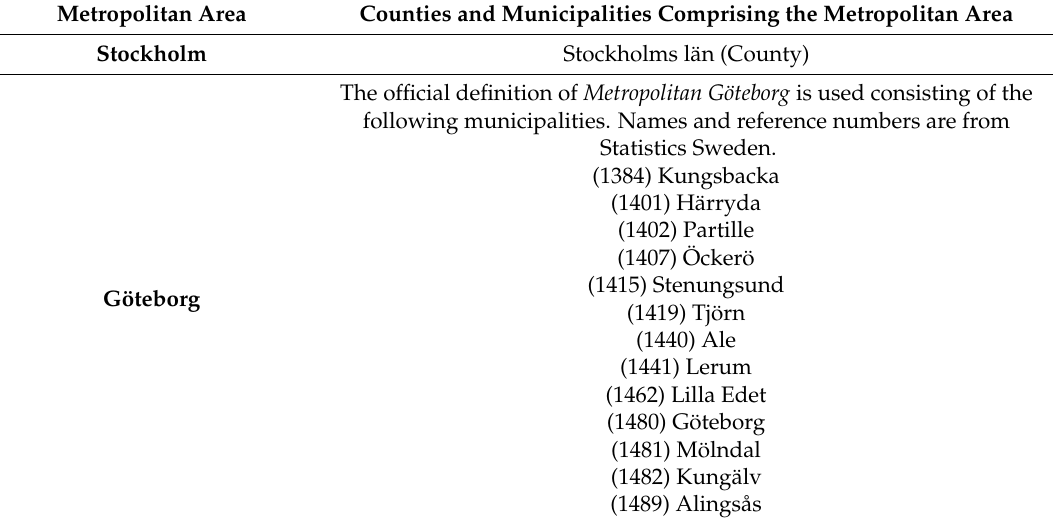
Table 1. Definitions of Swedish metropolitan areas in this study.